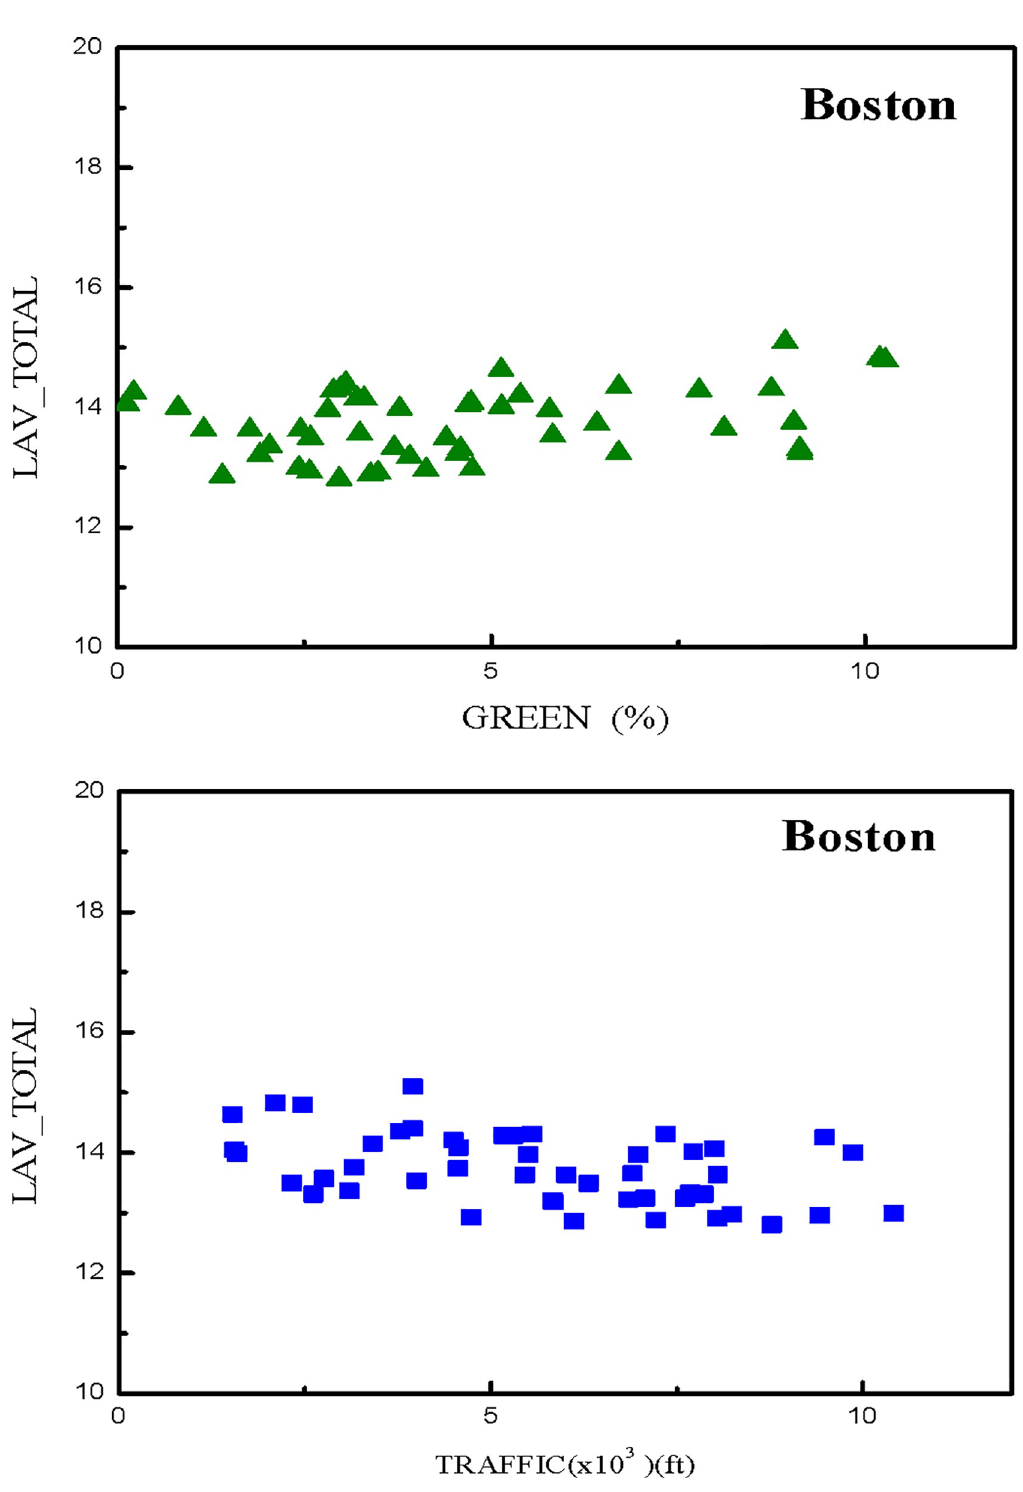
Fig 4. Data visualization to portray the relationships between property prices and selected features for (a) the green area percentage within a square unit; (b) the direct distance to the nearest station.